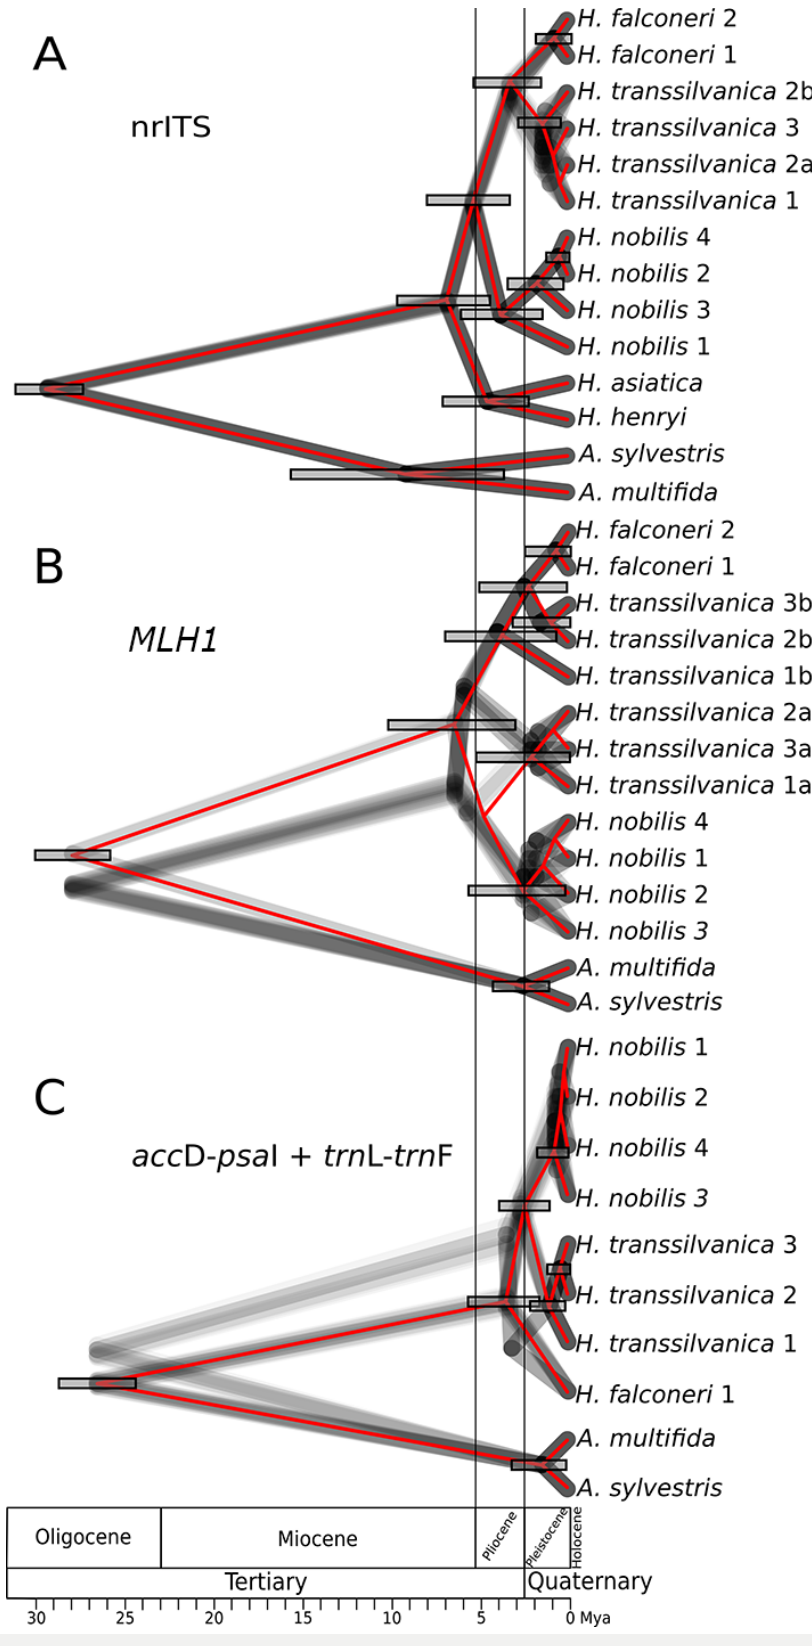
Figure 2 Dated phylogeny of a setof species as reconstructed by BEAST v.2.6.1. 95% highest posterior density (HPD) topology is visualized as grey overlapping phylograms. The maximum clade credibility (MCC) tree is projected on the tree set in red color. Error bars are only given for nodes with a minimum posterior of 0.5 and represent the 95%HPD age of the node. The geographic time scale is placed below the tree in the corresponding